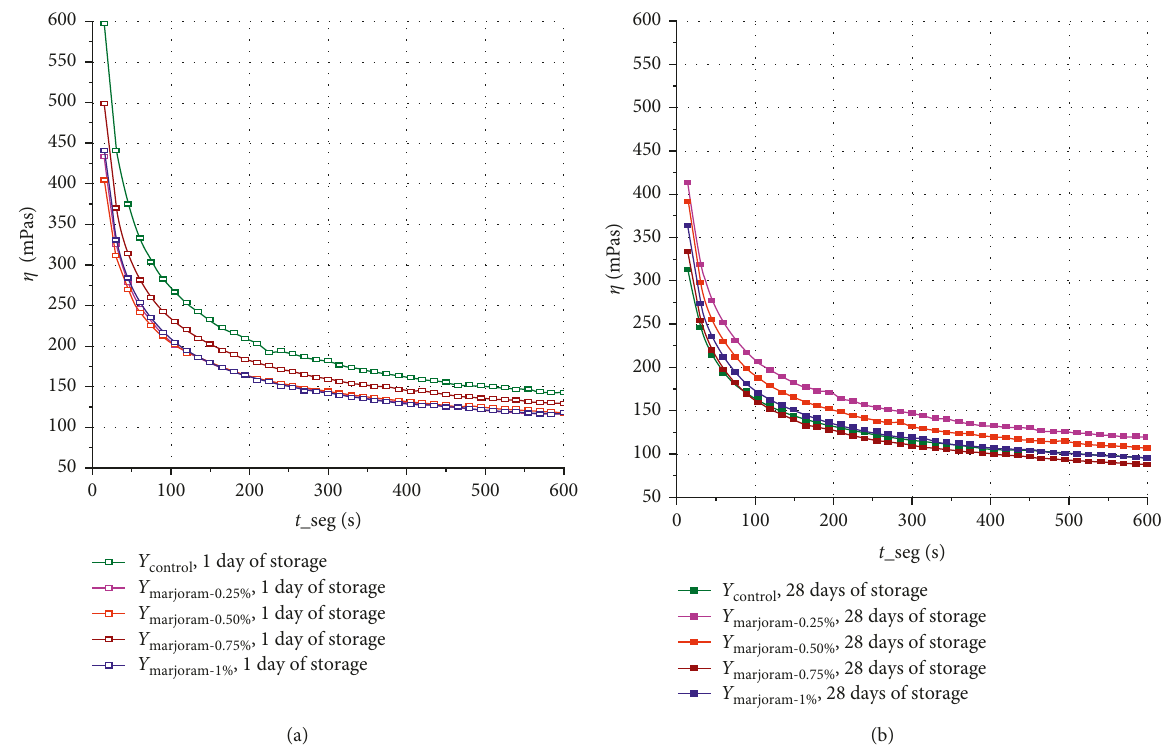
Figure 4: Curve of viscosity versus time of testing thixotropy of yogurt with marjoram ( Origanum vulgare L.) extract: (a) 1 day of storage; (b) after 28 days of